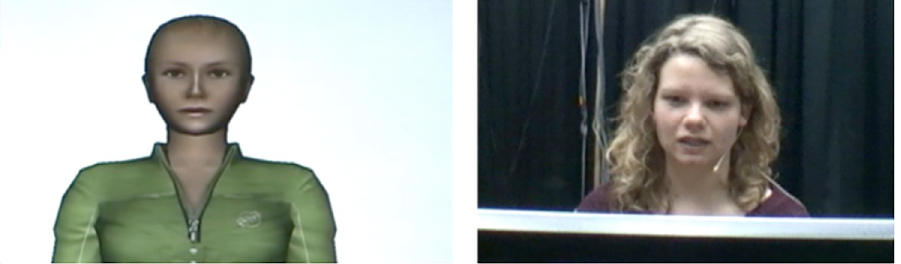
Fig 1. Virtual listener (left) interacting with human speaker (right) in the present experimental set-up (see also S2